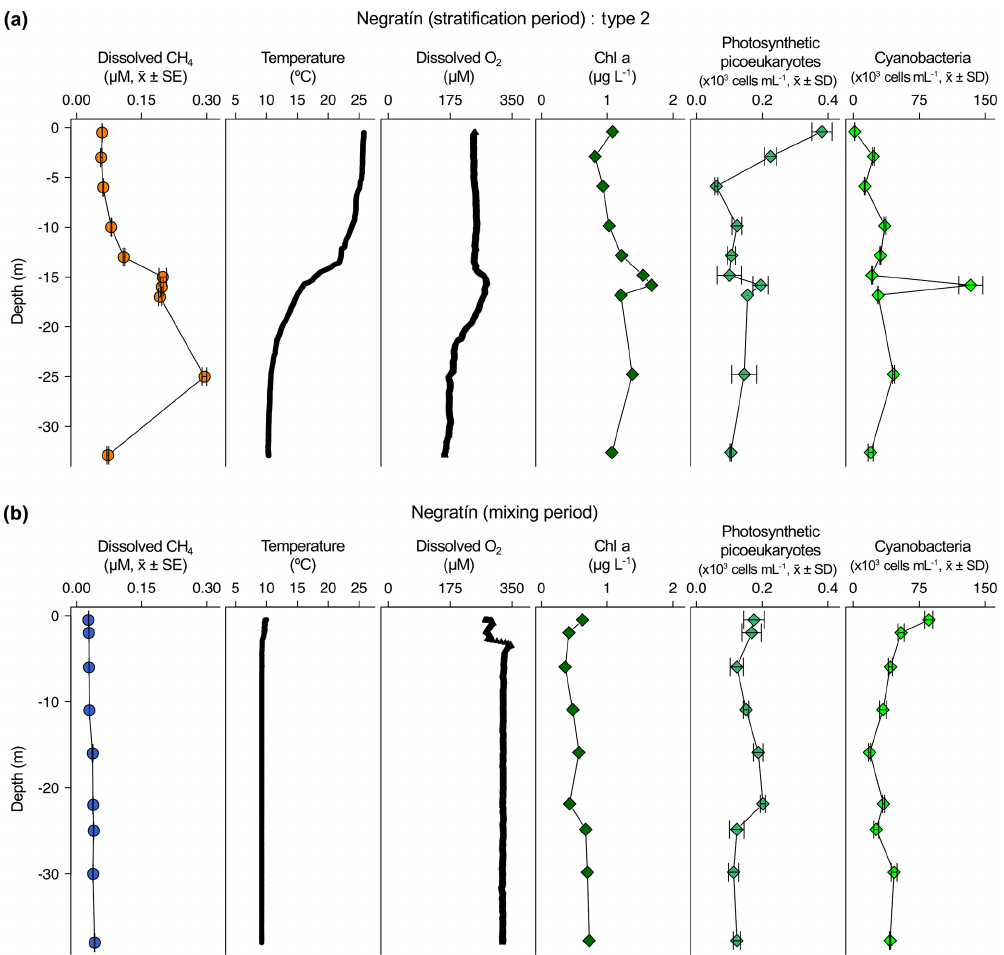
Figure 3. Vertical profiles of physicochemical and biological variables in Negratín reservoir. Dissolved methane concentration (CH 4 , µM, mean ± standard error), temperature ( ◦ C), dissolved oxygen (DO) concentration (µM), chlorophyll a (Chl a ) concentration (µgL − 1 ), abun- dance of photosynthetic picoeukaryotes ( × 10 3 cellsmL − 1 , mean ± standard deviation), and abundance of cyanobacteria ( × 10 3 cellsmL − 1 , mean ± standard deviation) during the stratification period (a) and the mixing period (b) . The sampling for the stratification period was on 27 July 2016 and 16 February 2017 for the mixing